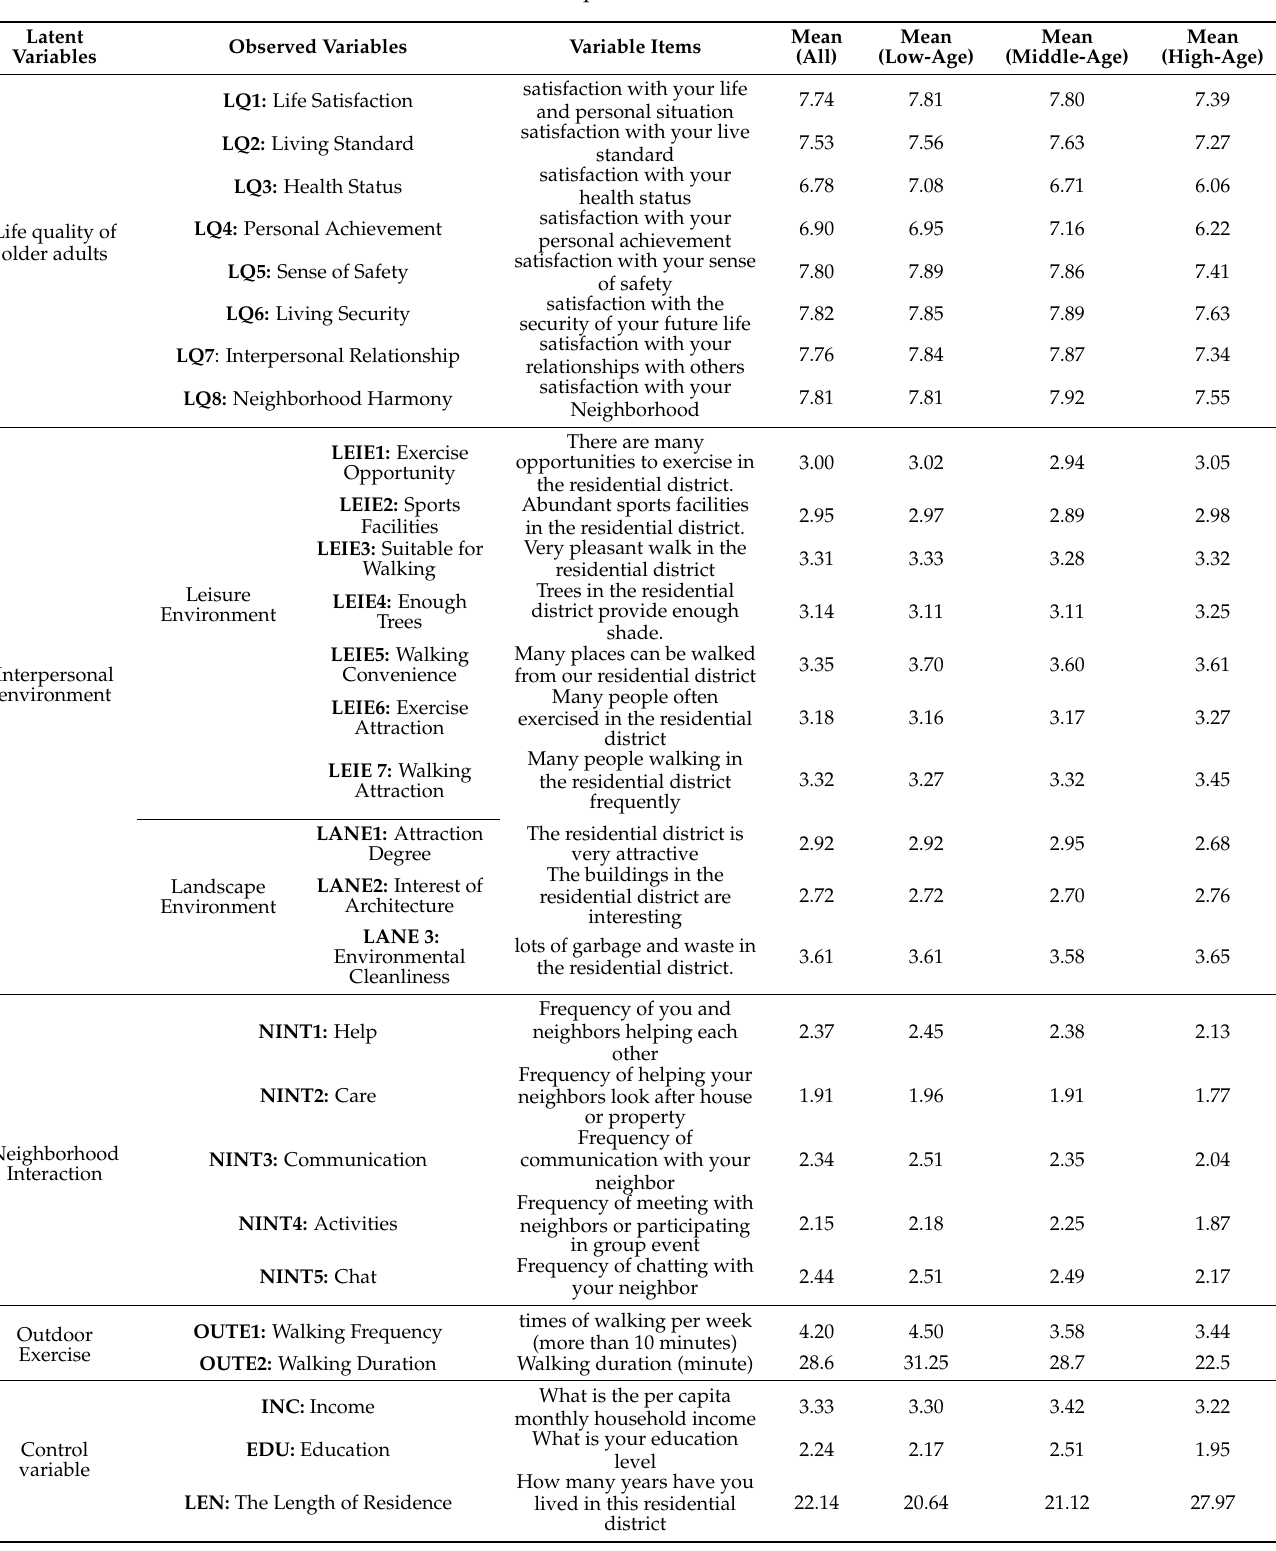
Table 1. Description of main